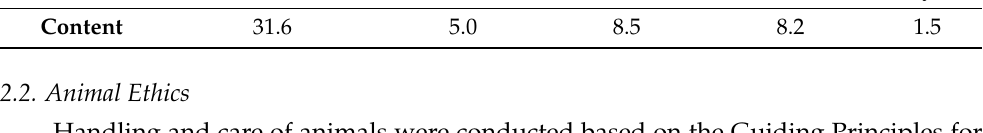
Table 1. The basic nutritional components of the artificial compound feed used in the farmed group (%). Items Crude